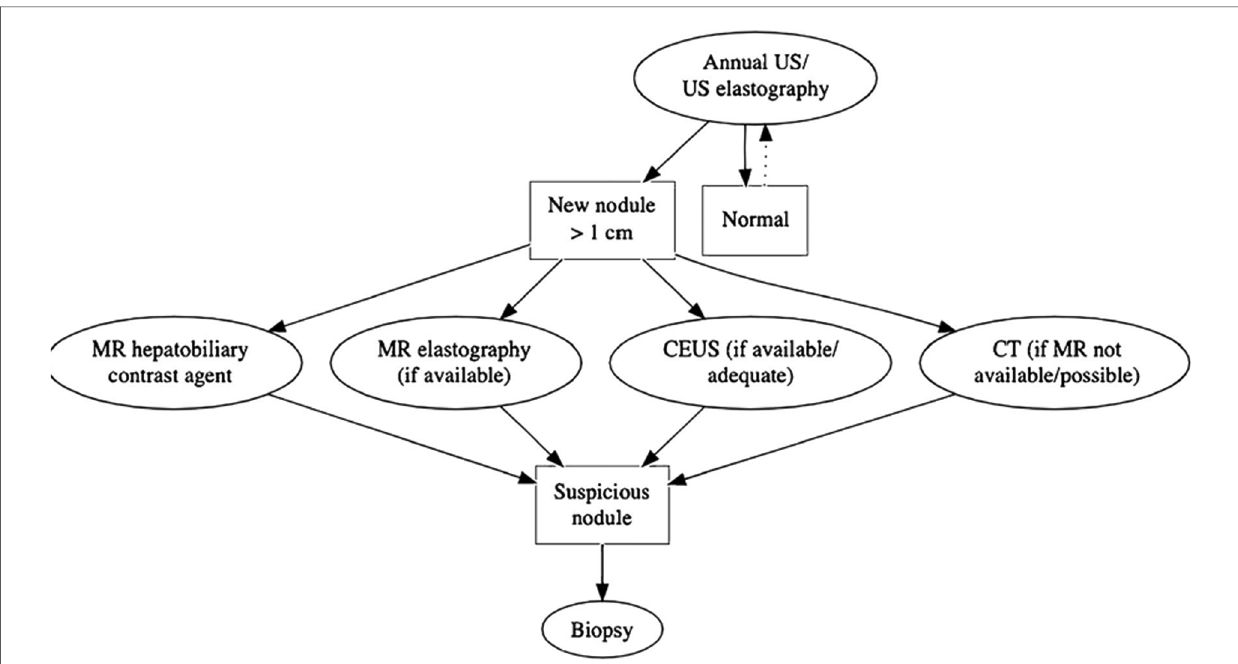
FIGURE 12 Flow chart of the proposed follow-up from the European Society of Pediatric Radiology, Abdominal Task Force. Reprint with permission from Perruca et al. Surveillance of Fontan associated liver disease: current standards and a proposal from the ESPR Abdominal Task Force. Pediatr Radiol . (2021) 51 :2598 –